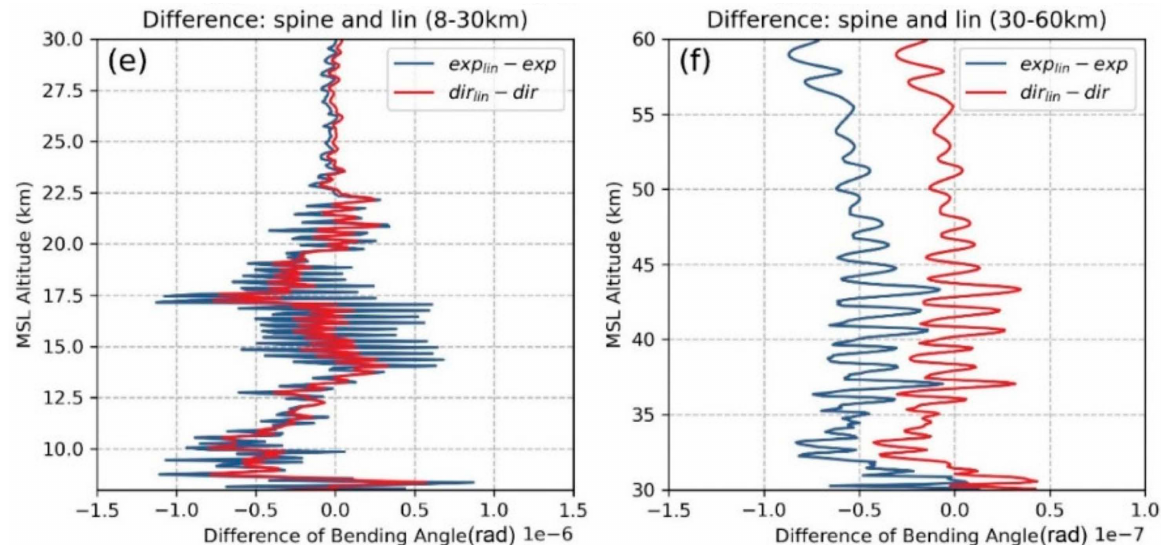
Figure A4. Mean difference from MetOp and experimental value calculated from direct and exp. ( a , b ) Difference (E − T) of BA based on the log-cubic interpolation; ( c , d ) difference of BA between exp and direct based on the log-linear and log-cubic interpolation; ( e , f ) difference of BA between log-linear and log-cubic interpolation based on exp and direct. ( a , c , e ) 10–30 km; ( b , d , f ) 30–60 km; Results from MetOp are the same as the results using FY3D.